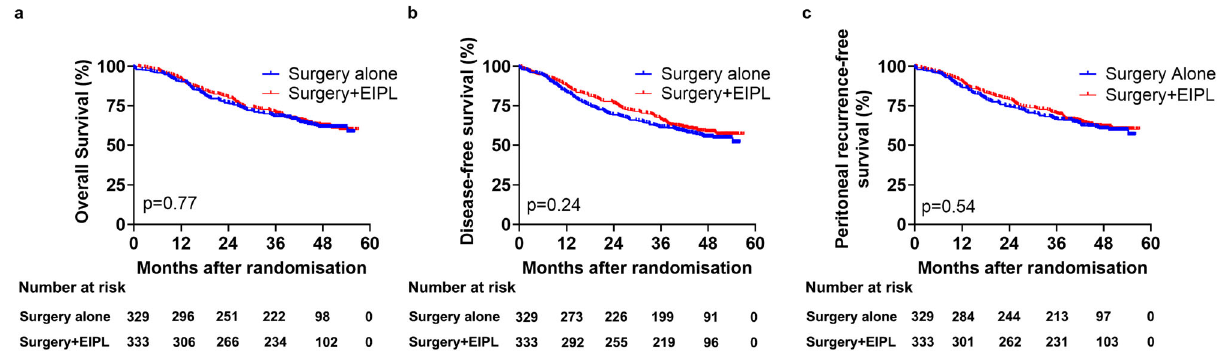
Fig. 2 Kaplan – Meier estimates of survival curves for the surgery alone and surgery + EIPL groups. Kaplan – Meier estimates of overall survival ( a ), disease-free survival ( b ), and peritoneal recurrence-free survival ( c ) in all randomized patients by treatment group. Log-rank test was used to compare both curves. EIPL extensive intraoperative peritoneal